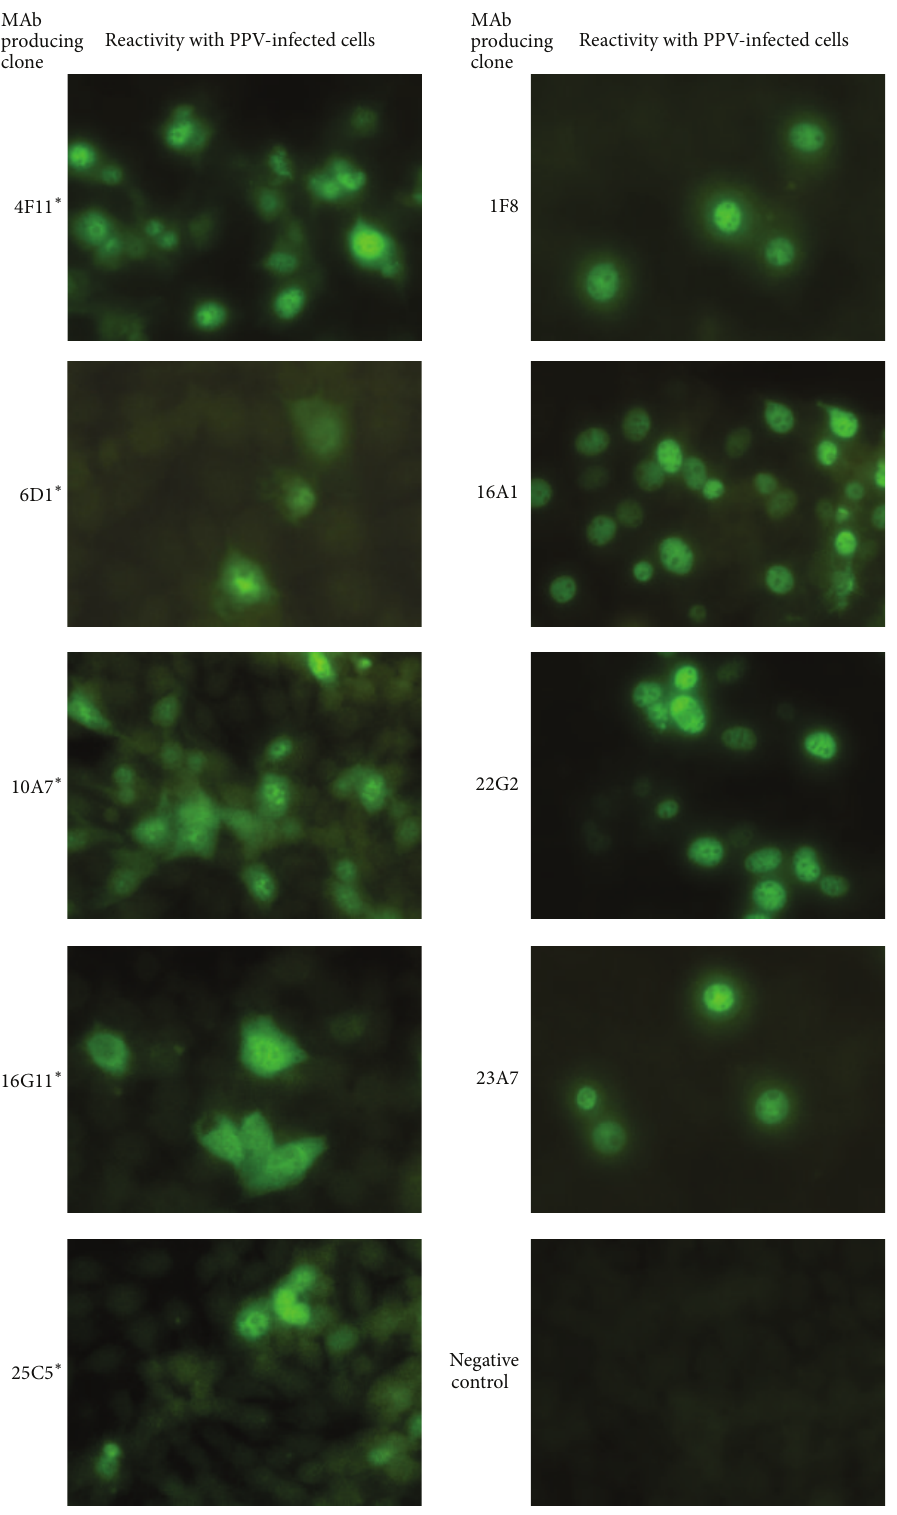
Figure 4: Fluorescence microphotographs showing the reactivity of 9 MAbs raised against yeast-derived PPV VP2 protein with PPV-infected cells on commercial slides (VMRD, Inc.). The codes of the MAbs are indicated on the left side of each picture. The MAbs recognizing linear PPV VP2 epitopes are indicated with an asterisk. As a negative control, negative control serum included in the kit is